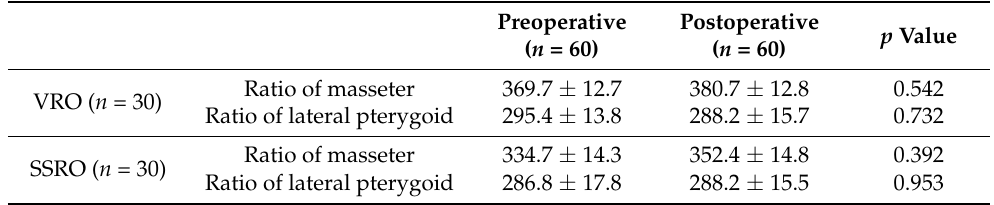
Table 2. Changes in volume-to-length ratios after a mandibular setback according to the surgical methods applied.